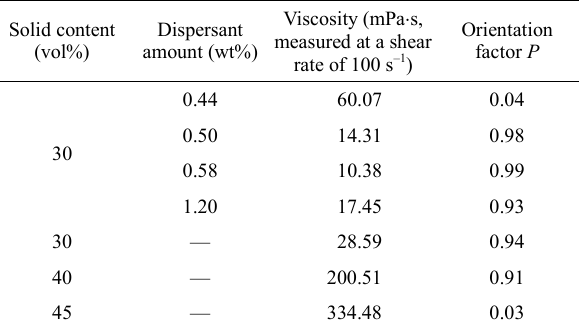
Table 2 Effect of dispersant amount and solid content on the viscosity of suspensions and texture degree of sintered α-Al 2 O 3 specimens [166] Viscosity (mPa ⋅ s, Solid content Dispersant measured at a (vol%) amount (wt%)